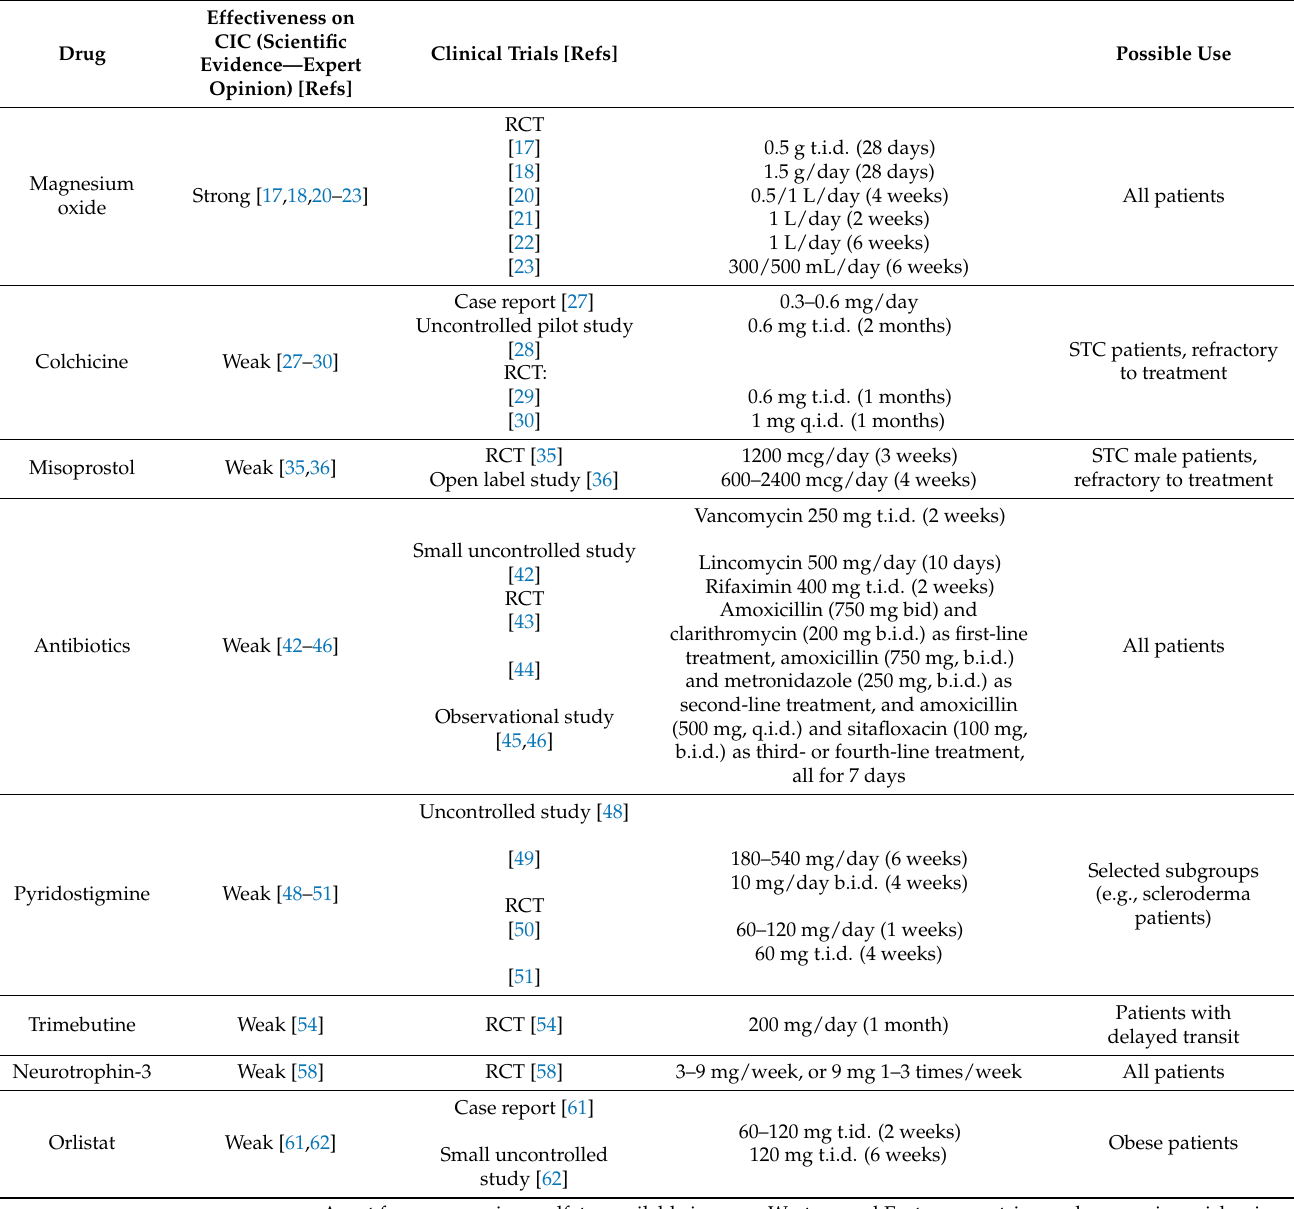
Table 1. Potential alternative treatments for chronically constipated